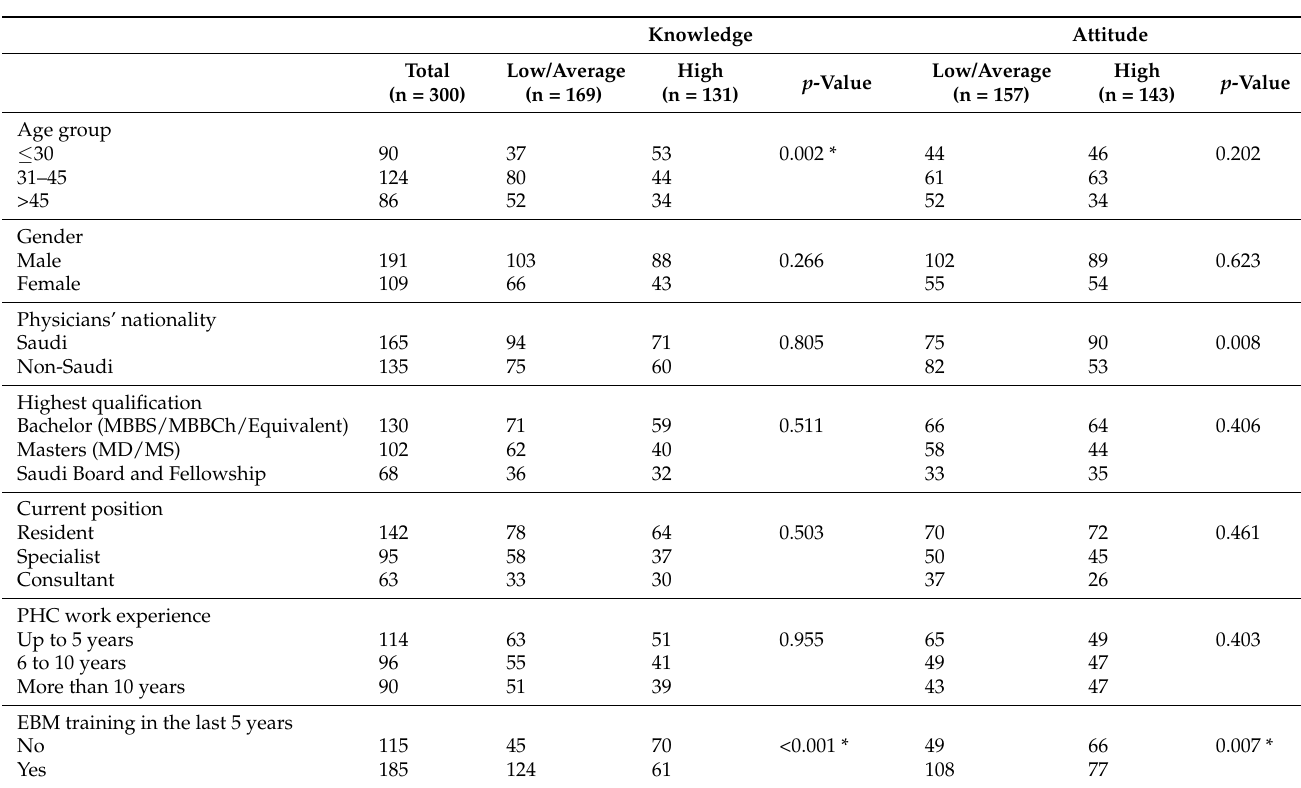
Table 4. Association between knowledge and attitude with the background characteristics of the study population (n = 300).